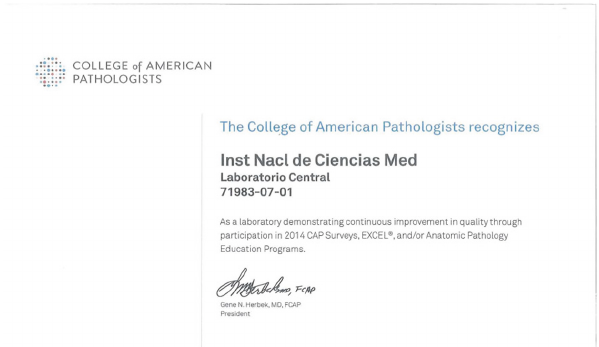
Figure 4: Certification of College of American Pathologists Lab- oratorio Central of the Instituto Nacional de Ciencias Medicas y Nutricion Salvador